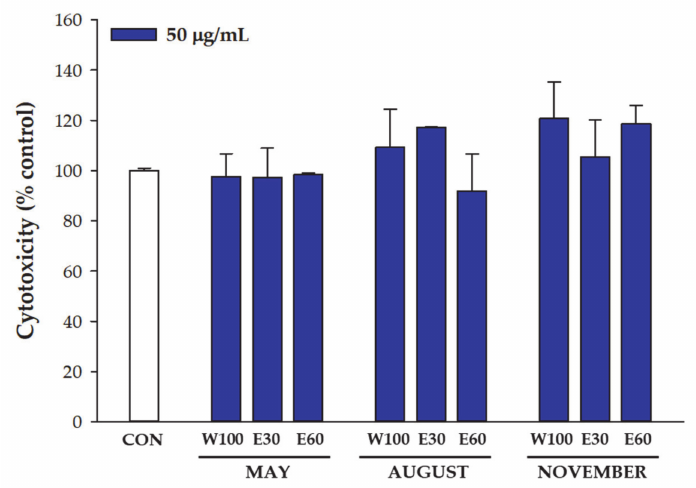
Figure 2. Cell viability of RAW264.7 macrophage cells treated with Dendropanax morbifera extracts. W100, hot water extracts; E30, 30% ethanol extracts; and E60, 60% ethanol extracts. Data are presented as the mean ± SEs of triplicate determinations of independent